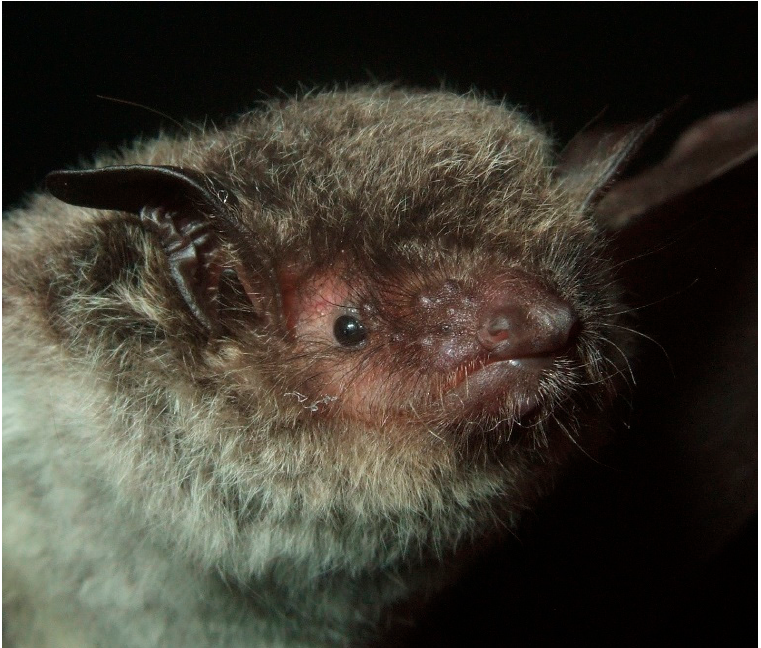
Figure 18. Myotis hasseltii , adult female Vu Dinh Thong.